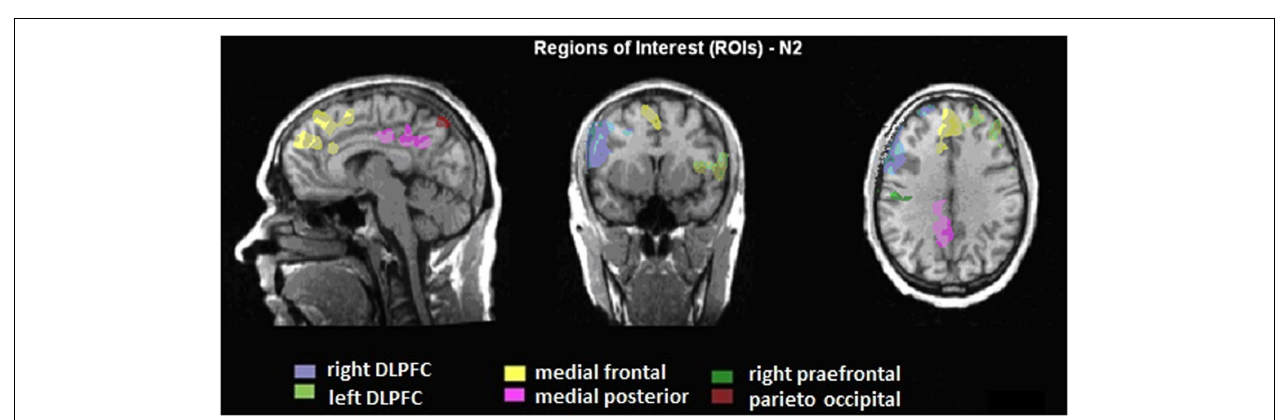
FIGURE 1 | Illustration of the single-trial coupling technique; (A) event-related potential (ERP); (B) the individual ERP amplitudes at each time-point after the presentation of the voluntary selection task